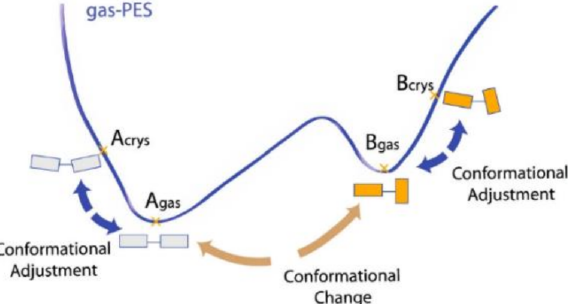
Figure 7. Schematic representation of the concepts of “conformation change” and “conformational adjustment” in a PES ( potential energy surface) profile. Reprinted with permission from Ref. [33]. 2014, American Chemical Society.